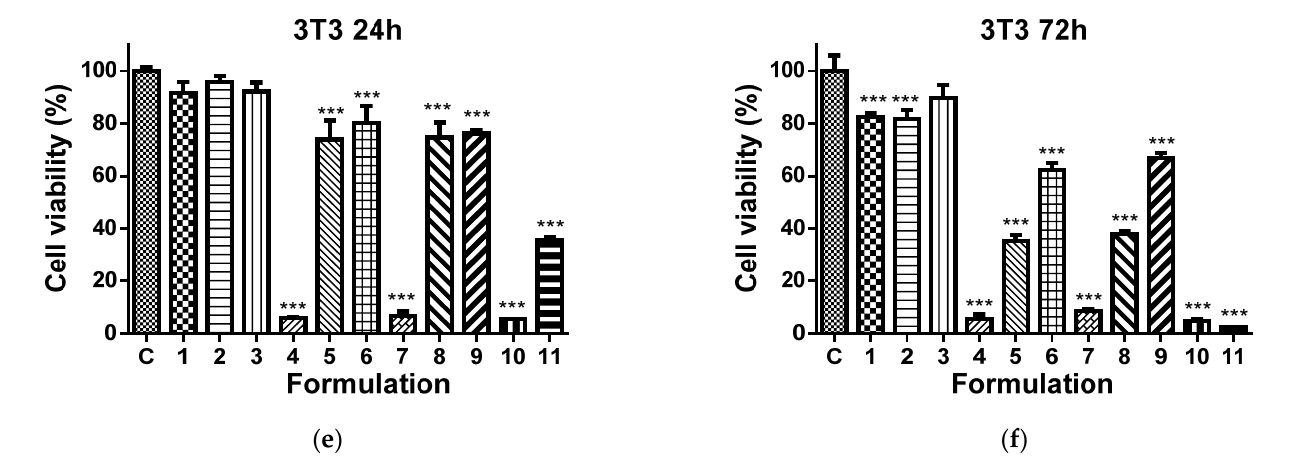
Figure 11. Effect of the different formulations on MCF-7 ( a , b ), HeLa ( c , d ), or BALB/c 3T3 ( e , f ) cells after 24 ( a , c , e ) and 72 h ( b , d , f ) of incubation. C—Untreated cells (control); 1—PLA mat; 2—Ch/PLA mat; 3—Ch-8Q/PLA mat; 4—Cu 2+ complex of Ch-8Q/PLA mat; 5—Fe 3+ complex of Ch-8Q/PLA mat; 6—aqueous solution of Jeff-8Q; 7—aqueous solution of Cu 2+ complex of Jeff-8Q; 8—aqueous solution of Fe 3+ complex of Jeff-8Q; 9—solution of 8QCHO; 10—solution of Cu 2+ complex of 8QCHO and 11—solution of Fe 3+ complex of 8QCHO. All 8Q-containing formulations were studied at a concentration of 8Q residues 60 µg/mL of culture medium. *** p < 0.001.